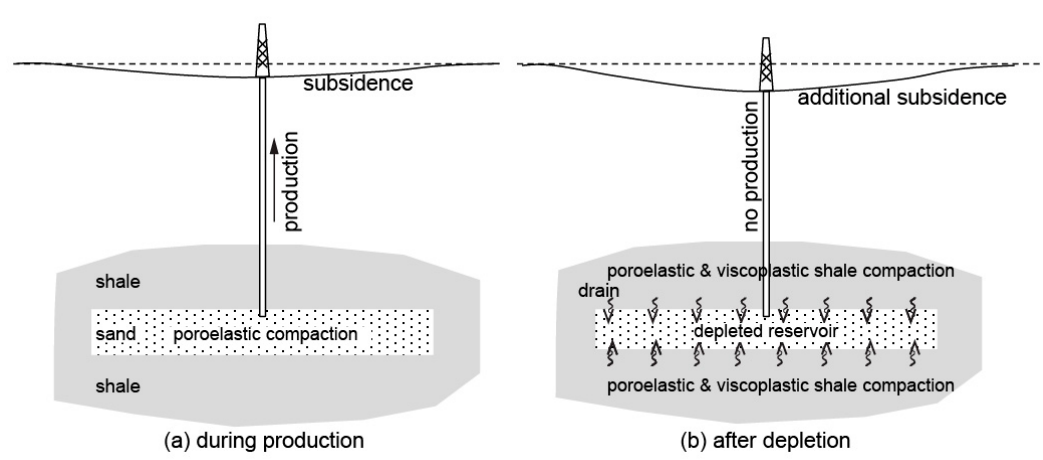
Figure 15. A simple compaction model of sand reservoir embedded with surrounding shale. It is assumed that during production stage, pore pressure depletion in a sand reservoir induces poroelastic compaction, and after depletion, a slow decrease in pore pressure in the bounding shale induces shale compaction in two independent rheological modes (poroelastic and viscoplastic) (modified from [29]).